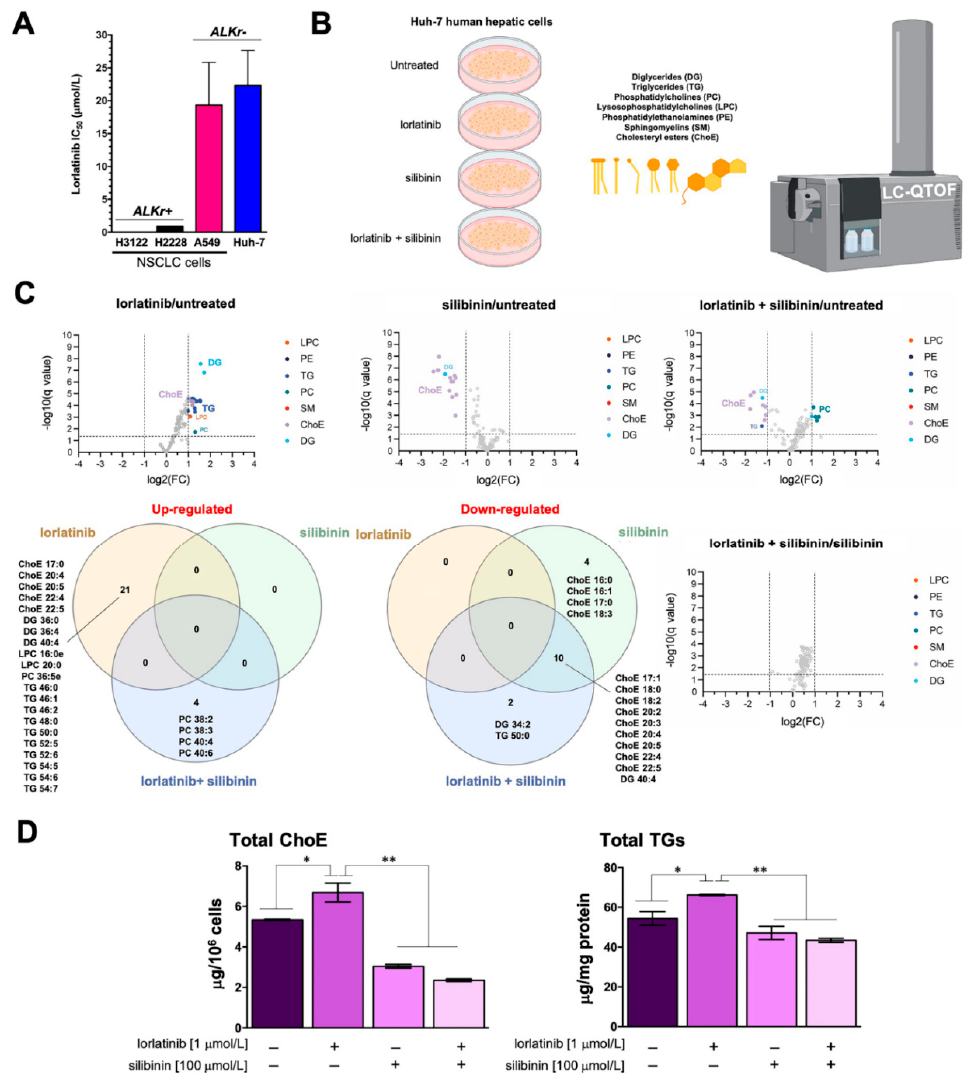
Figure 1. Silibinin prevents lorlatinib-driven lipidome alterations in human hepatic cells: ( A ) bar graphs of the IC 50 values for each cell line calculated from the MTT assays as described in “Materials and Methods”; the results are presented as the means ( columns ) ± S.D. ( bars ) ( n ≥ 3 in technical replicates); ( B ) to test the hypothesis that lorlatinib could directly promote the accumulation of triglycerides and/or cholesterol in human hepatocytes, we carried out an untargeted UHPLC-ESI-QTOF-MS/MS-based lipidomic analysis of > 100 molecular lipid species in Huh-7 cells cultured in the absence/presence of lorlatinib and/or silibinin; ( C ) Volcano plots and Venn diagrams of the results from lipidomic analyses ( B ) in human Huh-7 cells treated with lorlatinib (1 µ mol/L), silibinin (100 µ mol/L) or their combination for 48 h. Each dot represents a lipid species with its corresponding mean Log2 fold-change (FC) ( x axis) and Benjamini–Hochberg corrected p -value (-log10, y axis). Colored dots illustrate differential lipid species, using a cutoff of p < 0.05 and log2FC > 1 or <1. ( D ). ELISA-based quantification of cholesteryl esters ( left ) and triglycerides ( right ) in Huh-7 cells treated with lorlatinib (1 µ mol/L), silibinin (100 µ mol/L) or their combination for 48 h. p -values < 0.01 (*) and <0.001